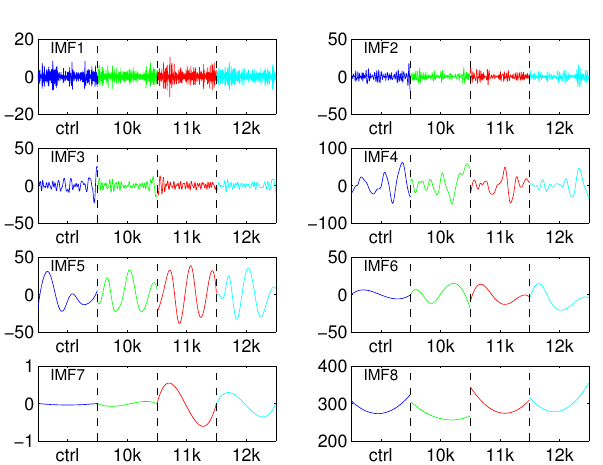
Fig. 8. The seven intrinsic mode functions (IMF1-7) and the long-term trend (IMF8) of 10 Be deposition (atoms/m 2 /s) at the Law Dome station.